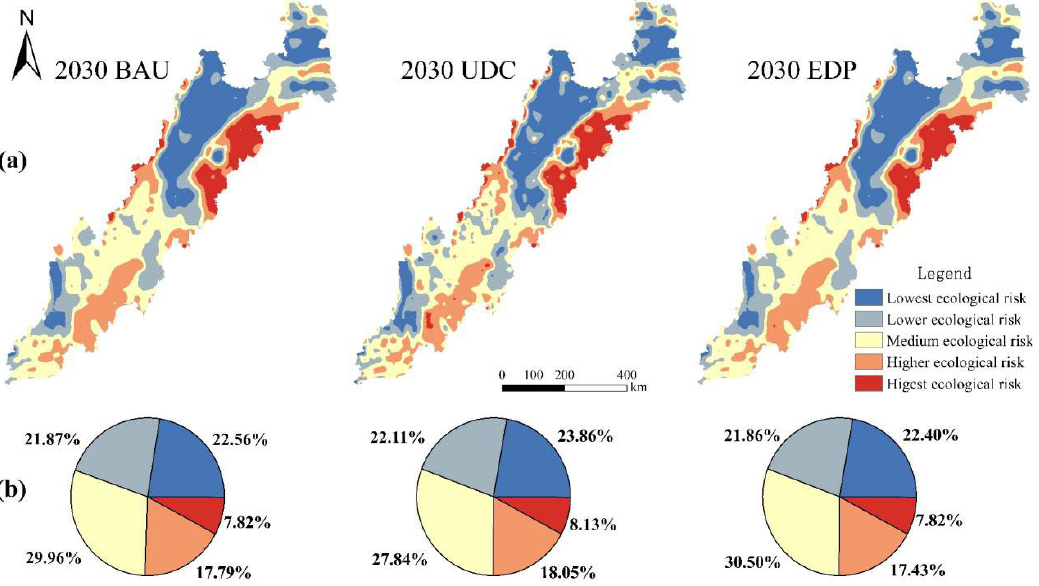
Figure 3. Spatial distribution ( a ) and proportion ( b ) of ecological risk in the Sichuan-Yunnan Eco- logical Barrier from 2000 to 2020.